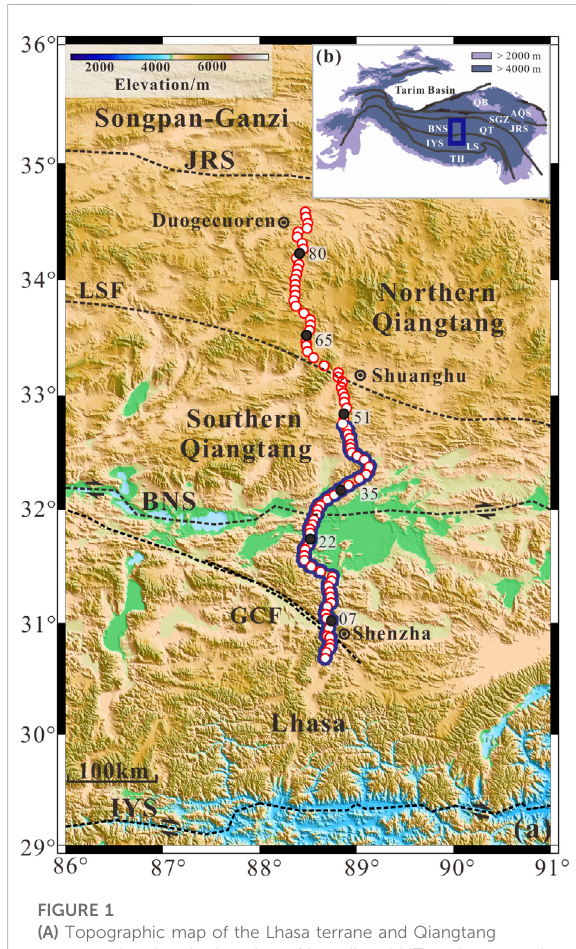
FIGURE 1 (A) Topographic map of the Lhasa terrane and Qiangtang terranes, showing the location of broadband MT stations as red circles (suture belt modi fi ed from Hou et al., 2015a); The blue curve represents the location of the deep seismic re fl ection pro fi le (Shi et al., 2021); Black circles represent the typical MT stations. (B) Inset shows the topography of Tibetan Plateau and its adjacent areas. The blue rectangle outlines the survey region; TH, Tethys-Himalaya terrane; LS, Lhasa terrane; QT, Qiangtang terrane; SGZ, Songpan-Ganzi terrane; QB, Qaidam basin; IYS, Indus-Yarlung Zangbo suture; BNS, Bangong-Nujiang suture; LSF, Longmu Tso-Shuanghu fault; JRS, Jinsha River suture; AQS, Animaqing suture; GCF, Gyaring Co